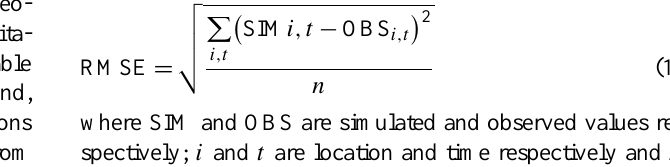
Figure 2 outlines the data flow and simulation